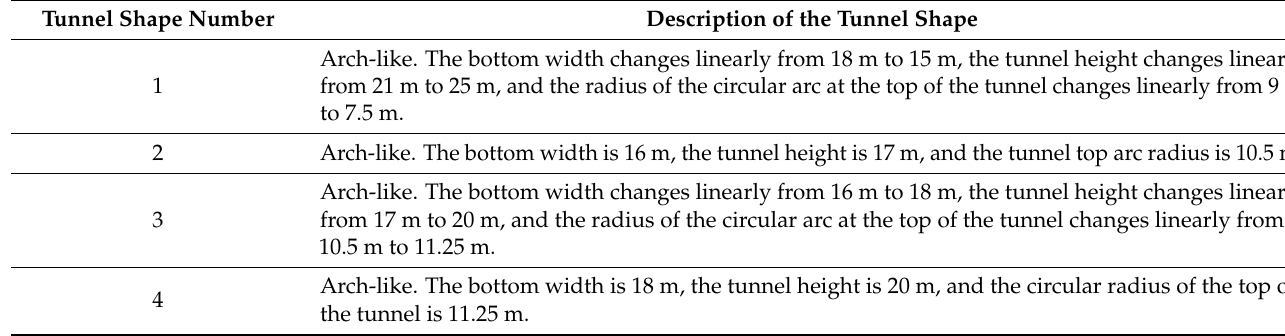
Table 2. Description of the tunnel